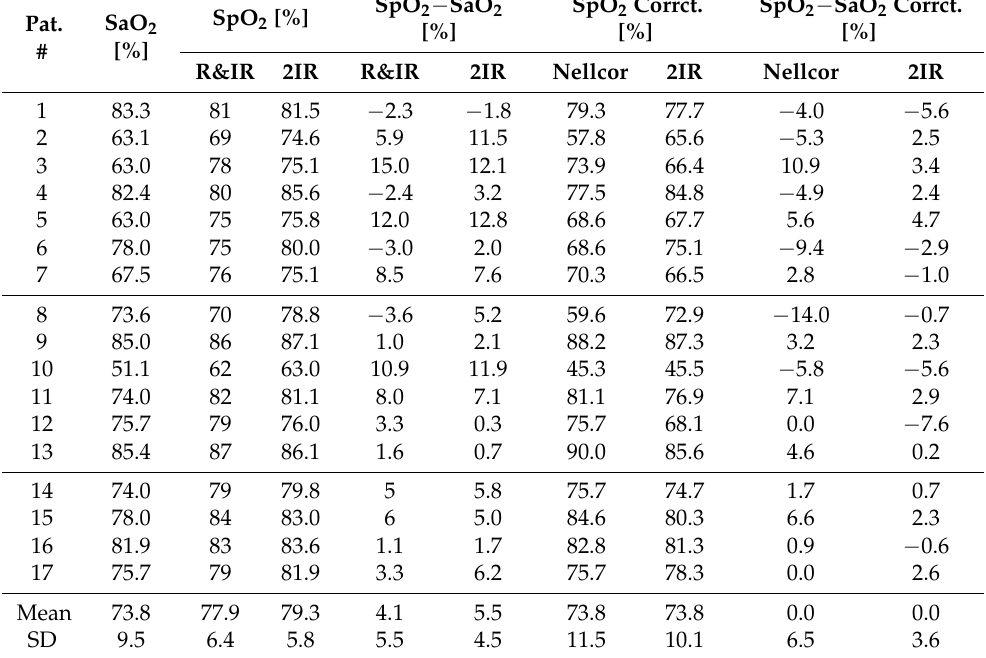
Table 1. Readings of SaO 2 and of SpO 2 , obtained by emitted red and infrared light (SpO 2 _R-IR) and by light with two wavelengths in the infrared region (SpO 2 _2IR). Corrected SpO 2 _R-IR and SpO 2 -2IR are also presented. The average and the standard deviation (SD) of SpO 2 − SaO 2 are also shown.